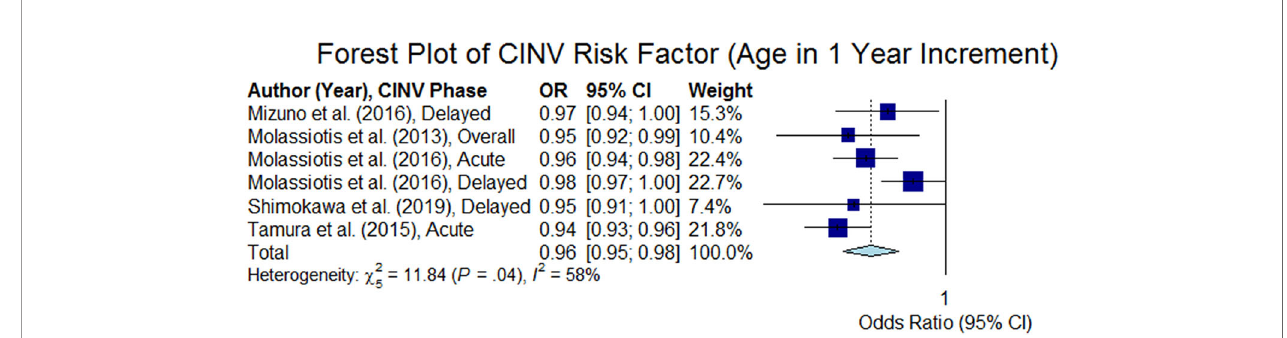
FIGURE 3 | Forest plot of Chemotherapy-Induced Nausea and Vomiting (CINV) risk factor (age in 1 year